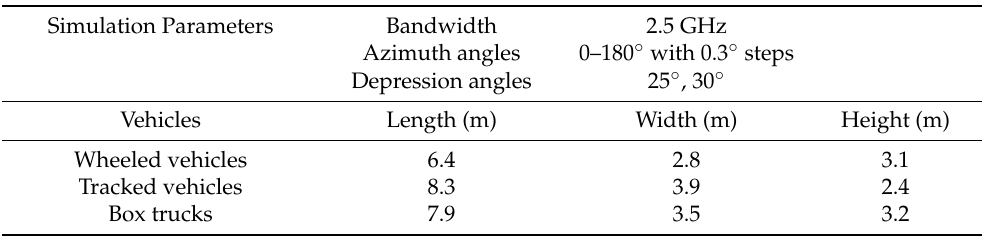
Table 3. Parameters of vehicles and radar in the experiments.